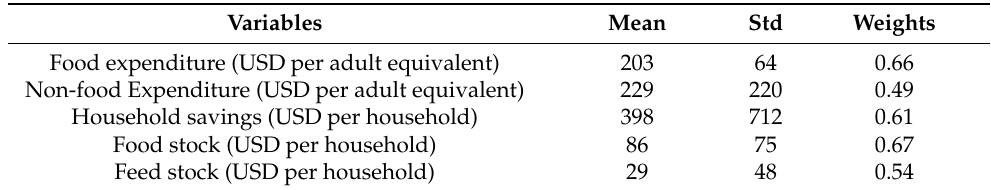
Table 2. Means, standard deviations, and weights generated from PrincipalComponent Analy- sis